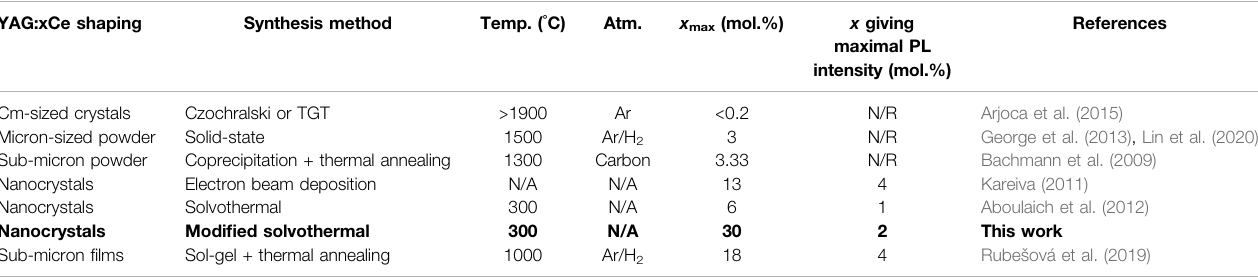
TABLE2| SummaryofmaximalCeconcentration, x max ,inYAGaccordingtothecrystalsizeandsynthesismethodandofCeconcentrationgivingthehighestPLintensityfor each method. YAG:xCe